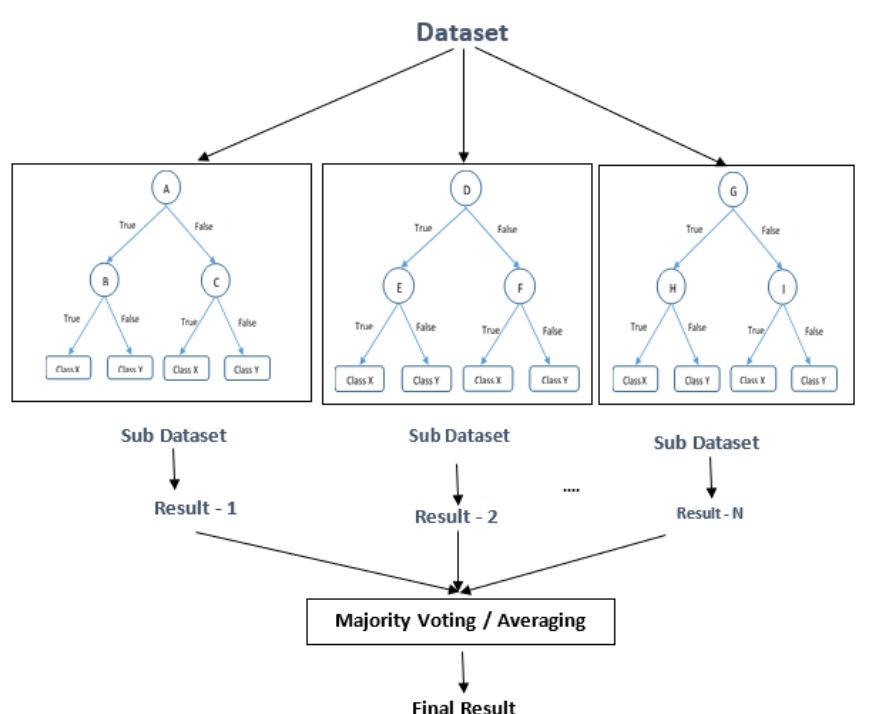
Figure 4. The RF which consists of three different decision trees. Each one was trained using a subset of the training dataset.